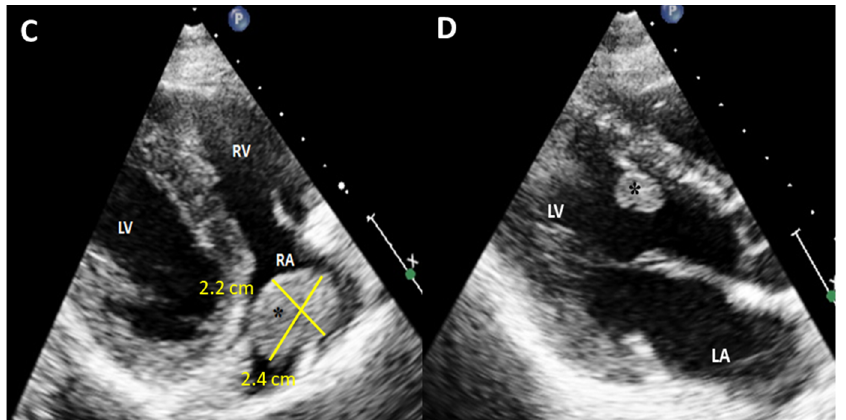
Figure 1. Initial scan: Transthoracic echocardiogram images, four chamber apical view ( A , B ) and parasternal long axis view ( C , D ). Multiple masses in the cardiac chambers are marked with black asterisks. A 30-year-old Caucasian man with a history of an in-situ melanoma of the forehead, which was surgically excised four years earlier, was referred for cardiac evaluation because of tachycardia and elevated levels of serum troponin. The patient had presented three months ago to the oncology clinic, with dry cough and pigmented skin nodules on the left shoulder, left forearm, chest, and forehead. Abdominal and brain computed tomography (CT) scans showed several metastatic lesions in the liver, the spleen, and the brain, while the histologic evaluation of one of the skin lesions revealed metastatic melanoma. Being BRAF-unmutated, the patient was initially treated with a combination of nivolumab and ipilimumab but due to grade 3 colitis, the treatment was replaced by a combination of dacarbazine and carboplatin. During clinical examination he was hemodynamically stable and his electrocardiogram showed sinus tachycardia at 120 beats per minute. The echocardiogram revealed multiple masses attached to the walls of both ventricles and the right atrium (RA) while no mass was detected in the left atrium (LA) ( A ). A large intracavitary mass (3.8 cm × 2.0 cm) was occupying almost one third of the right ventricle (RV) while a lobular right atrial nodule (2.4 cm × 2.2 cm) was attached to the posterior wall of the RA by a small pe- duncle ( B , C ). Additionally, a small mass in the left ventricle (LV) was attached to the interventric- ular septum ( D ). The end-diastolic RV volume was severely reduced by the mass, resulting in compensatory tachycardia, while there was no significant tricuspid valve inflow obstruction. The biventricular function was mildly reduced. A cardiac magnetic resonance (CMR) imaging con- firmed the multifocal myocardial infiltration and the intracavitary masses and excluded the pres- ence of thrombus in any of the cardiac chambers (Figure 2). Diffuse metastatic involvement pre- cluded surgical management. One month later the cardiac metastases in RA and LV were un- changed on echocardiogram, while the tumor in RV was enlarged occupying the majority of the chamber, resulting in further reduction of the cardiac output and tachycardia (Figure 3, Supple- mental Video S1). The treatment was changed to a combination of dacarbazine and carboplatin, but the patient eventually died two months later. Our case illustrates a rarity of metastasis of a malig- nant melanoma of to the heart providing useful information for doctors in training and practition-